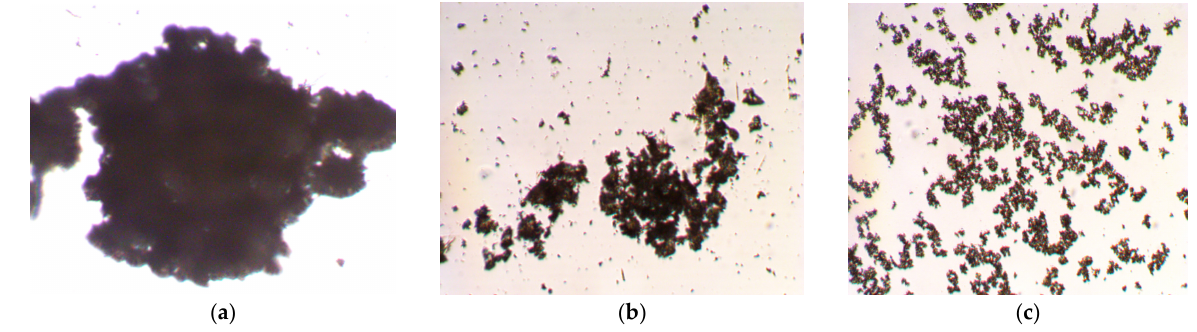
Figure 4. Influence of complexation with HP β CD on 2a solubility (photomicrographs at ×10 magnification): suspensions of 2a ( a ) and HP β CD-2a prepared by PM ( b ) and KM ( c ). C 2a = 1 mg/mL, C HP β CD = 12 mg/mL, pH 7.4.